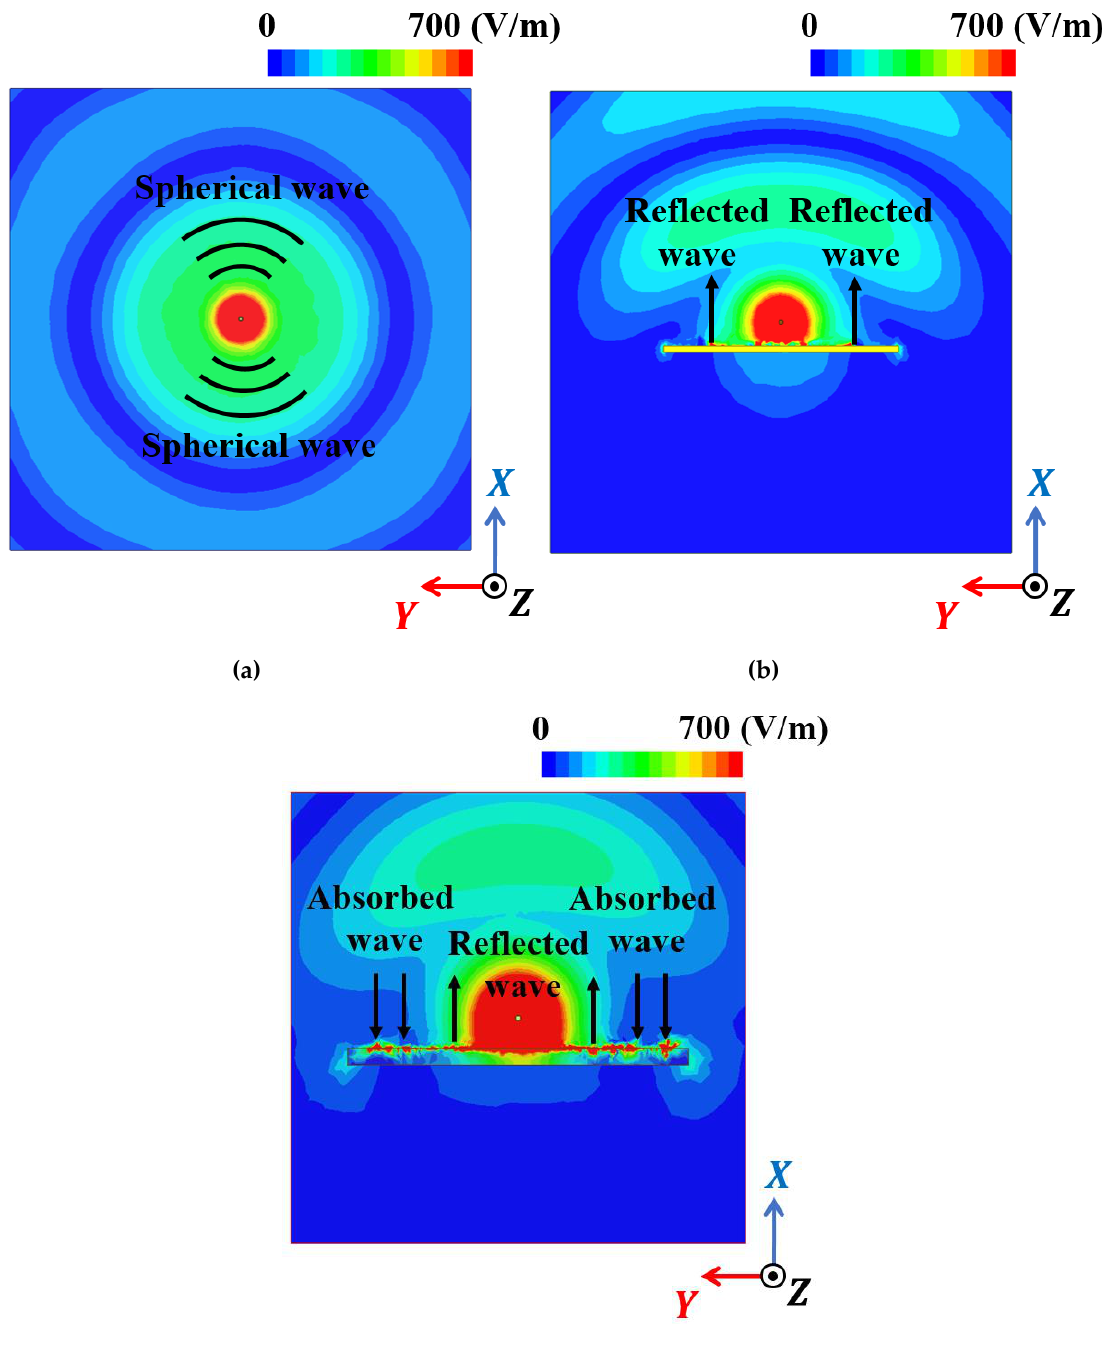
Figure 10. Simulated electric field distribution top views for ( a ) reference 1 (monopole), ( b ) reference 3 (monopole antenna with AMC), and ( c ) proposed (monopole with MM) antenna.